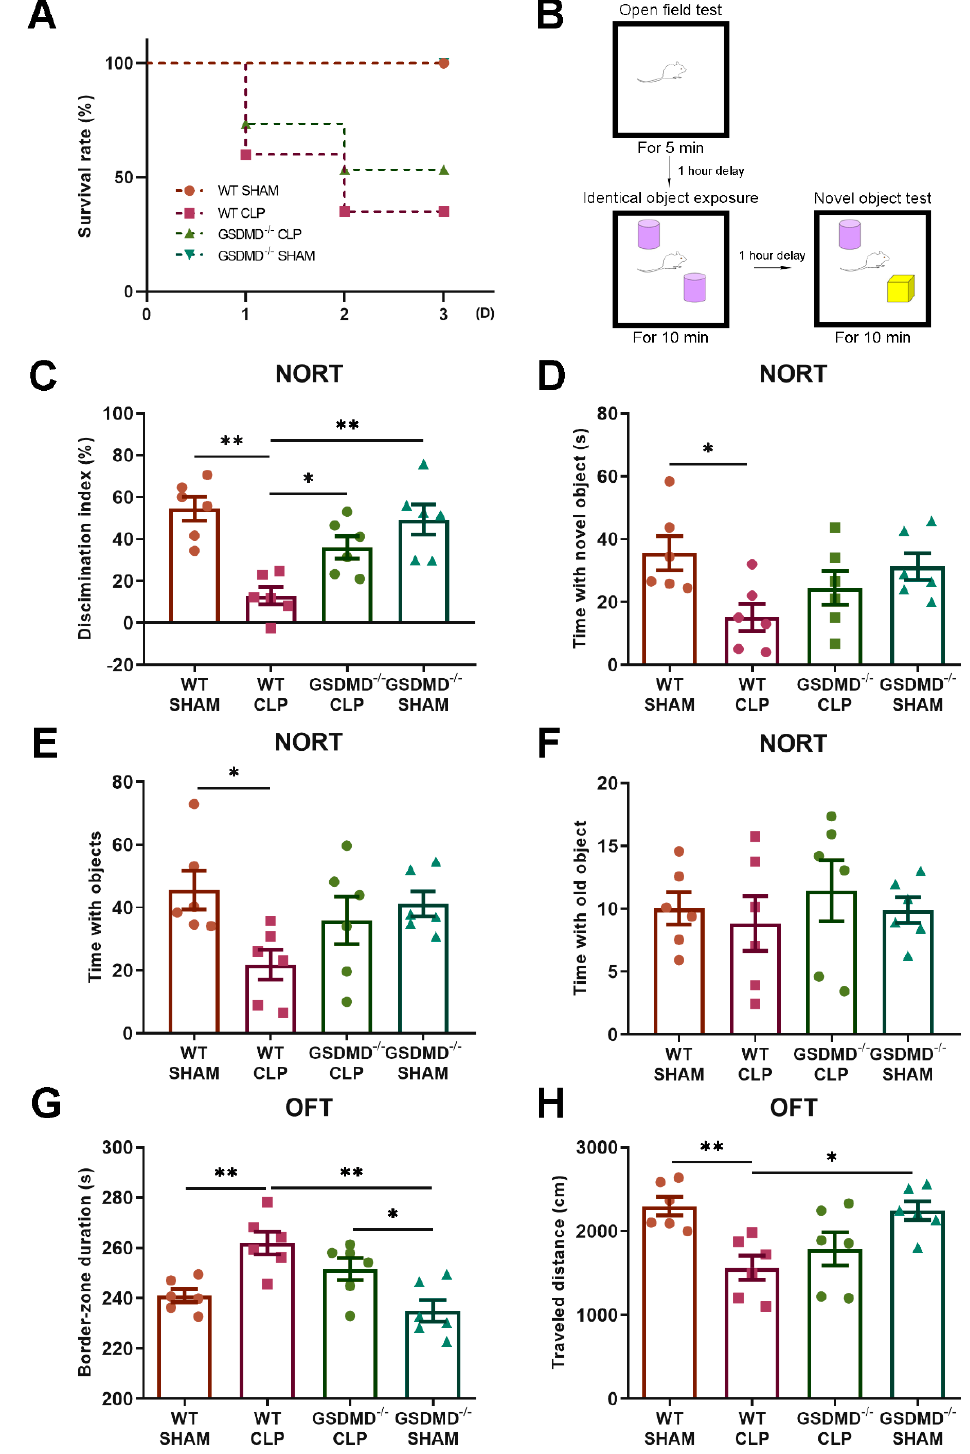
Figure 1. The absence of GSDMD improves the survival rate and behavioral outcomes of CLP-induced SAE in mice. ( A ) Survival curve. Seven of twenty wild-type CLP mice and eight of fifteen GSDMD − / − CLP mice survived until day 3 after surgery. No mice died in the sham groups. ( B ) Schematic of OFT and NORT. ( C − F ) Discrimination index, time with novel object, time with objects, and time with old object in the NORT, respectively (n = 6 per group). ( G , H ) Border-zone duration and traveled distance in the OFT, respectively (n = 6 per group). * p < 0.05, ** p < 0.01.